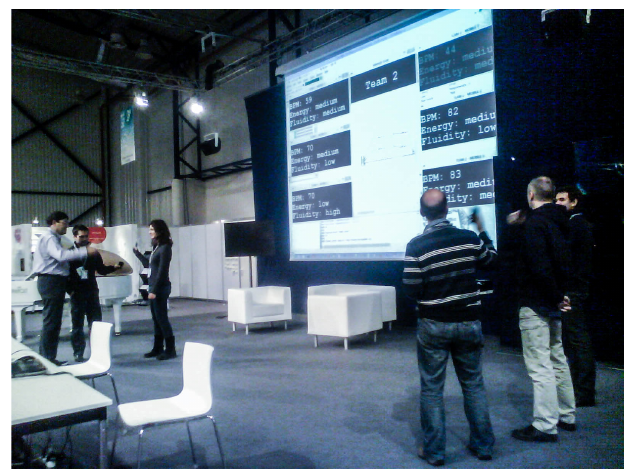
Figure 1. The SIEMPRE Podium Performance presented at the Art & ICT Exhibition that took place in Vilnius (LI) in November 2013. Two teams of three performers are interacting by shaking their mobile phones: on the screen some technical data about participants is shown; team 2 is exhibiting higher cohesion and synchronisation, thus the music piece retrieved by team 2 will emerge over the one selected by team